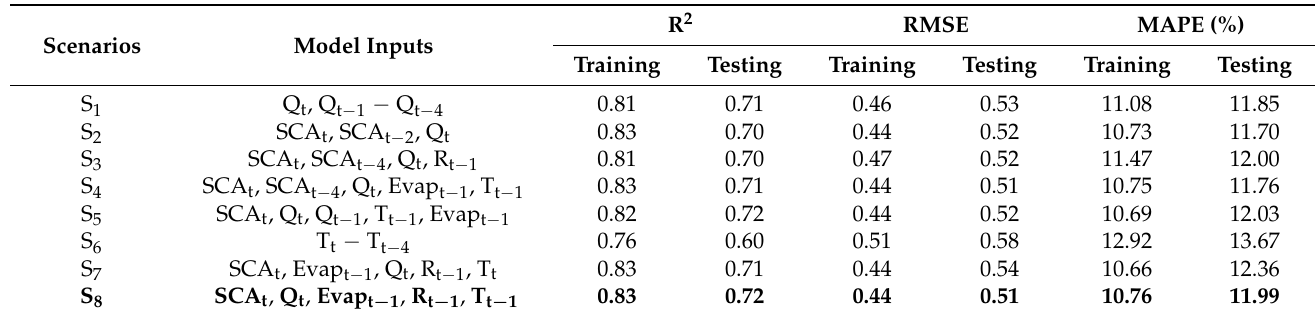
Table 8. Training and testing statistics of the RM5Tree algorithm using various input combinations for the Gilgit River basin.